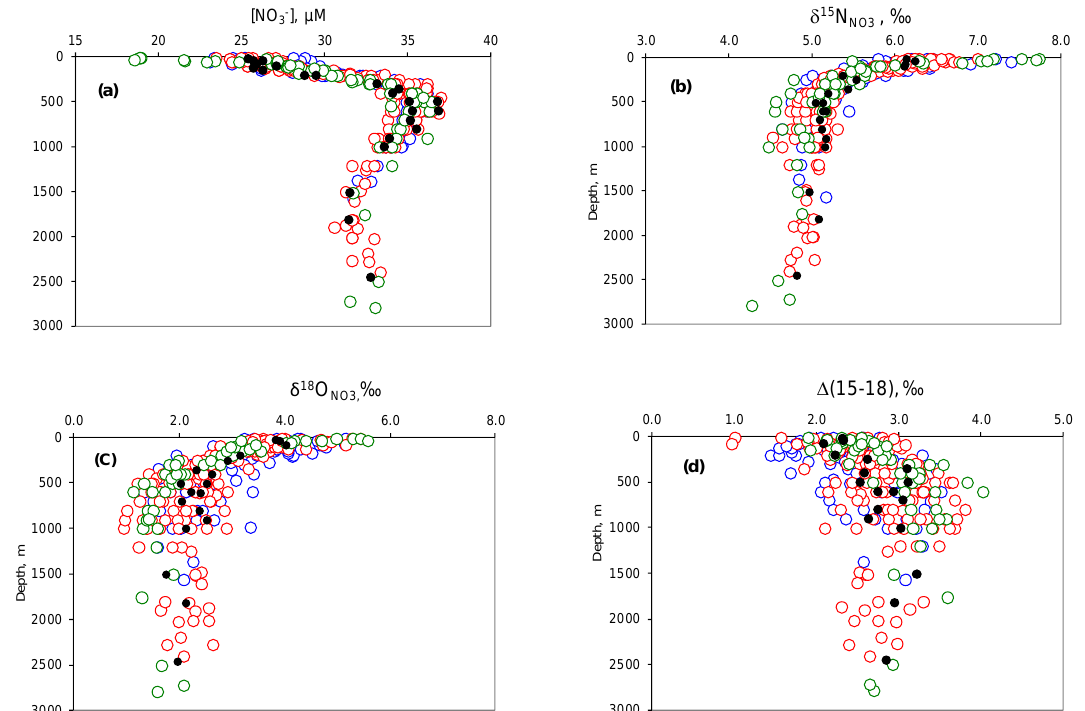
Figure 2. Water column profiles of (a) NO − stations; red circles: Meander stations; green circles: Polar Front and north of PF stations; filled black circle: reference station